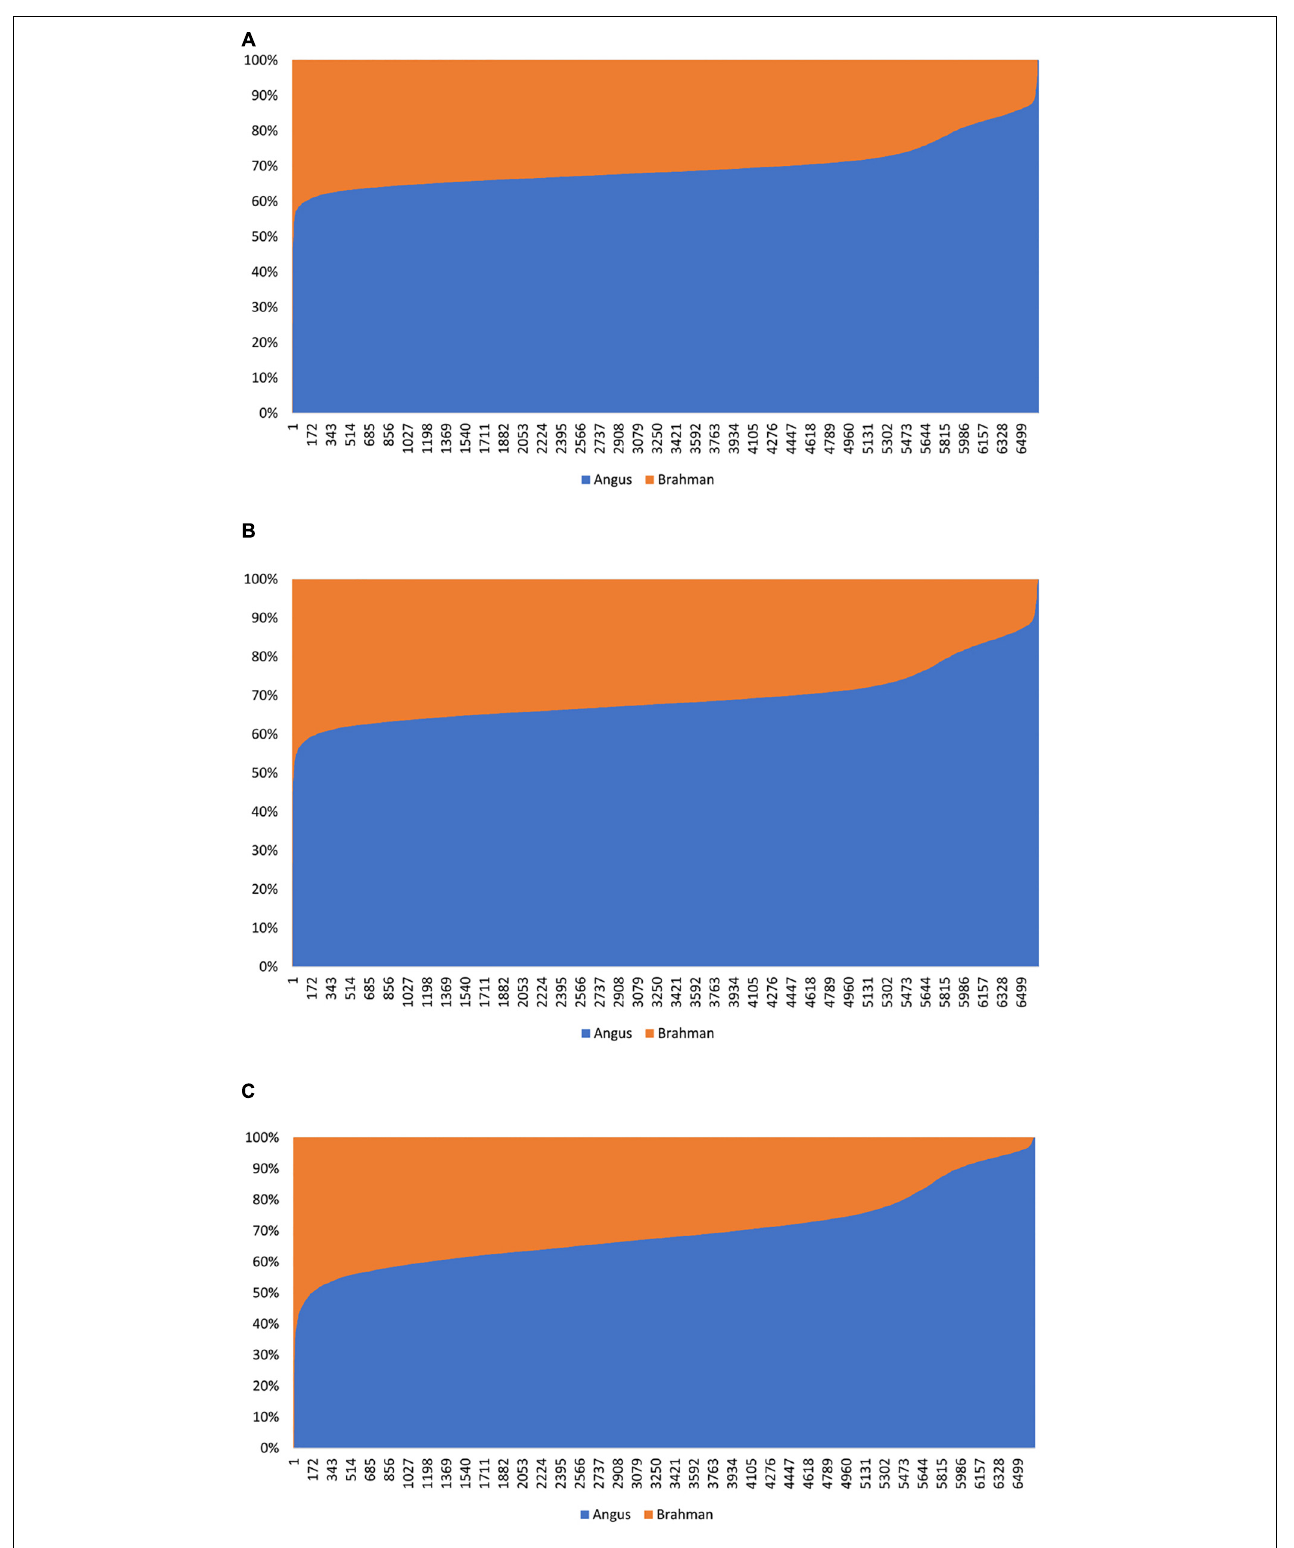
FIGURE 2 | Distribution of estimated genomic breed composition for 7,969 Brangus animals in ascending order of their Angus composition, obtained using three statistical methods: (A) admixture model, (B) linear regression, and (C) path analysis (D-GBC).